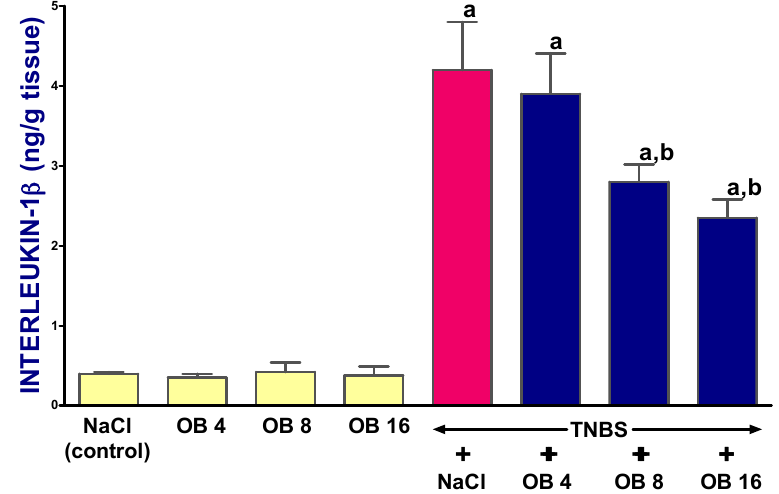
Figure 5. Effect of saline (NaCl) or obestatin given at doses of 4 nmol/kg (OB4), 8 nmol/kg (OB8), or 16 nmol/kg (OB16), and TNBS-induced colitis on mucosal concentration of interleukin-1 β (IL-1 β ) in the colon. Mean ± SEM. n = 10 in each group of animals. a p < 0.05 when compared with control; b p < 0.05 when compared with colitis + NaCl.